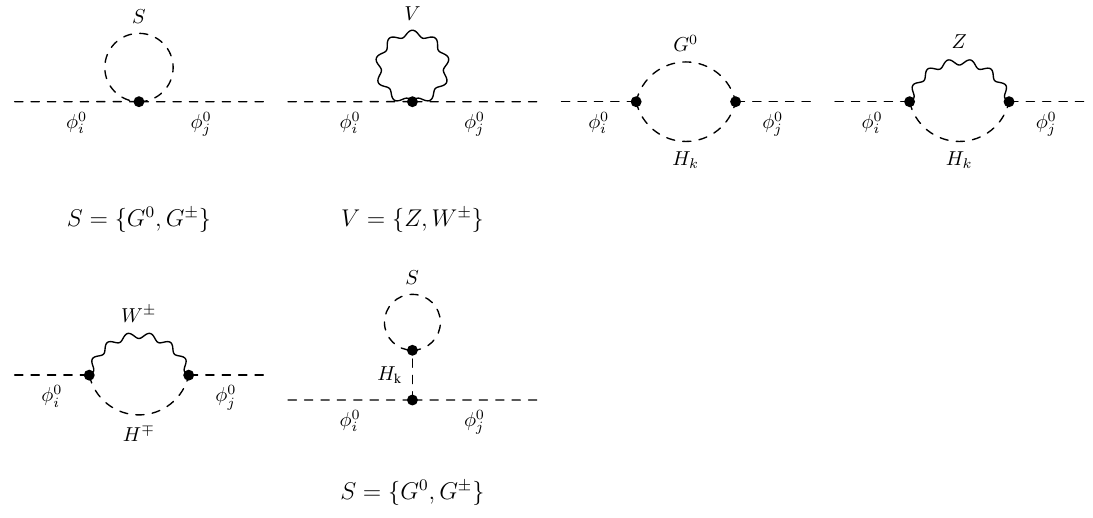
Figure 15 . All Feynman diagrams contributing to the gauge-dependence of the CP-odd self- energies (cid:6) tad ( p 2 ) where (cid:30) 0 2 f A; G 0 g . A sum over intermediate Higgs states H k is i;j (cid:30) 0 i (cid:30) 0 j